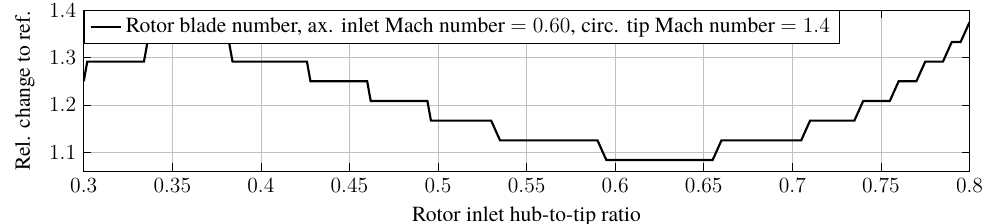
Figure 12. Exemplary relative change in the blade number over the hub-to-tip ratio in the fan stage.